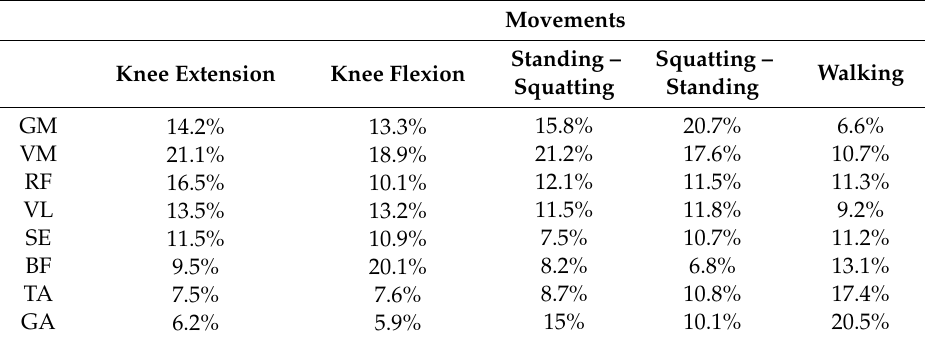
Table 1. Muscle contribution of various movements.